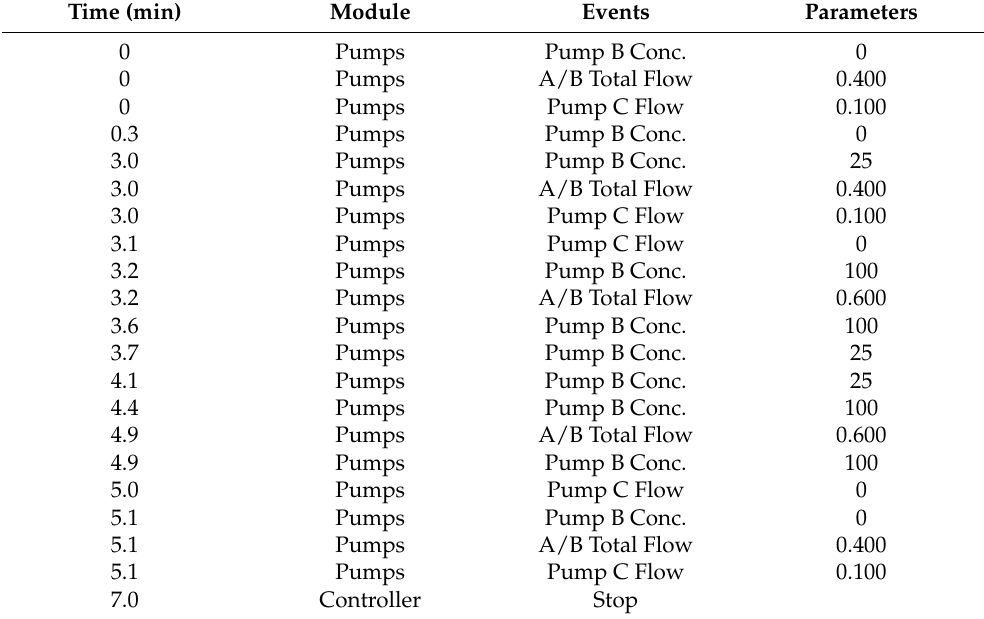
Table 6. LC gradient and flow rate